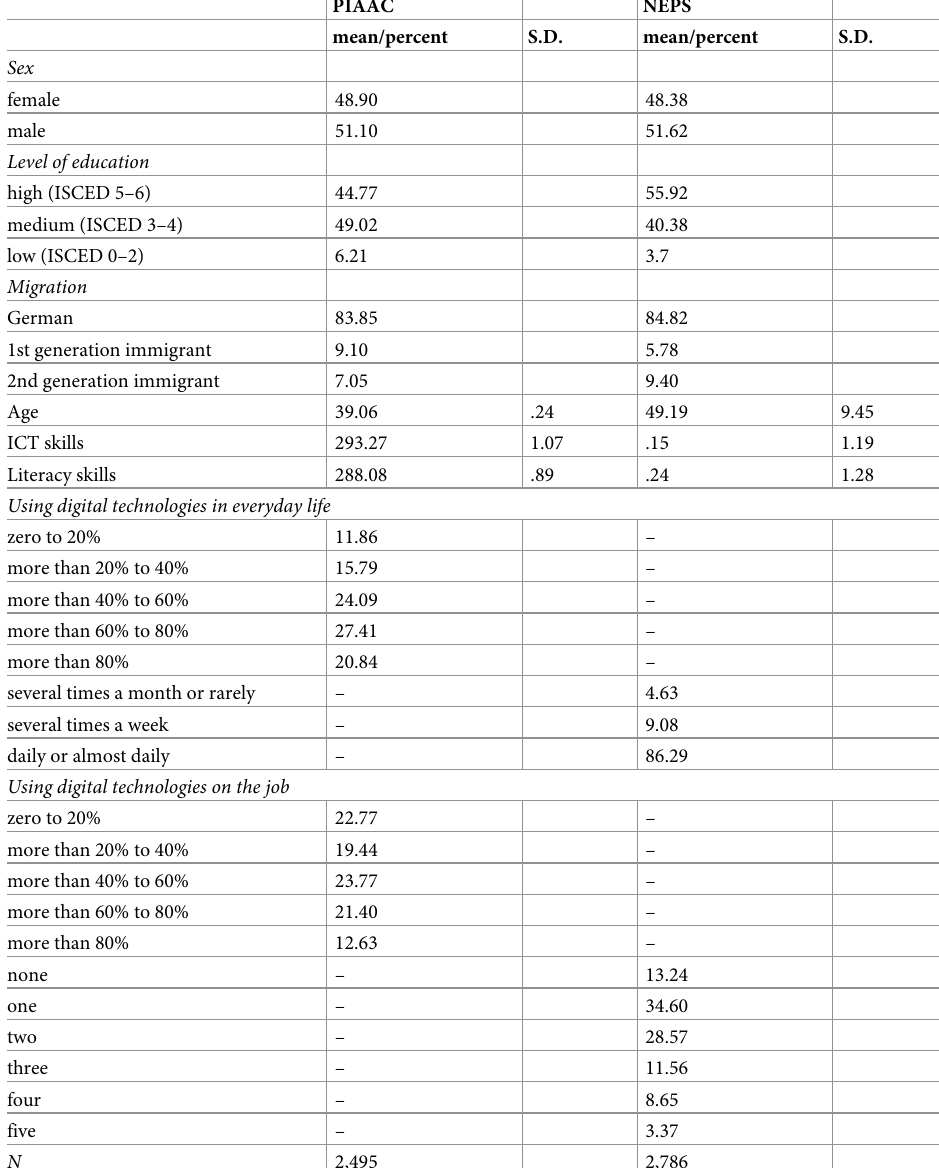
Table 1. Basic statistics of individual-level